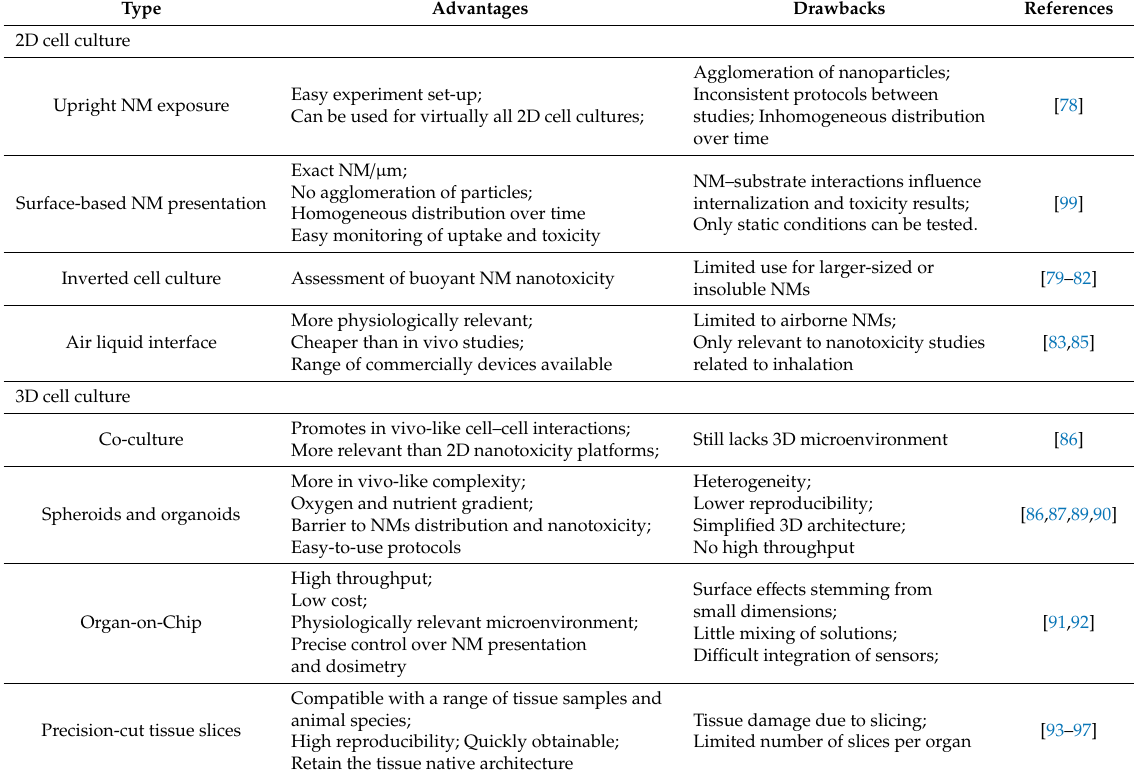
Table 1. The advantages and drawbacks of the various in vitro